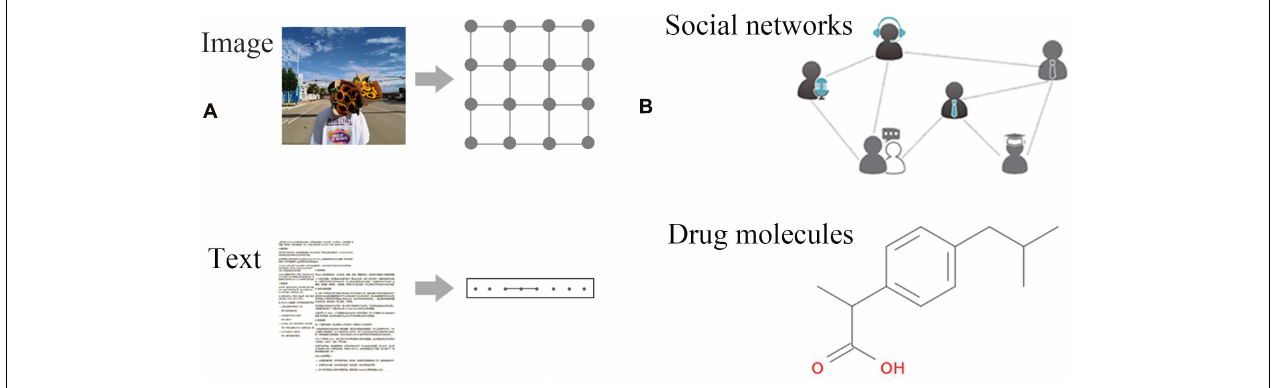
FIGURE 1 | Examples of Euclidean and non-Euclidean data. (A) Euclidean data: regular data such as images, text, video, voice, etc. These data are characterized by excellent translation invariance, that is, the number of neighbor nodes of each node is fixed. (B) Non-Euclidean data: social networks, chemical molecular structures, knowledge graphs, etc.; each node has an unfixed number of neighbors.